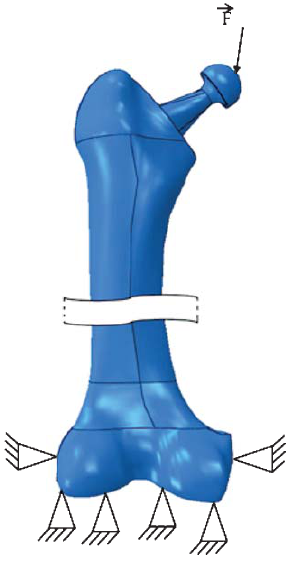
Fig. 4. Boundary condition showing the force vector acting on the head and the fixation of the distal epiphysis.